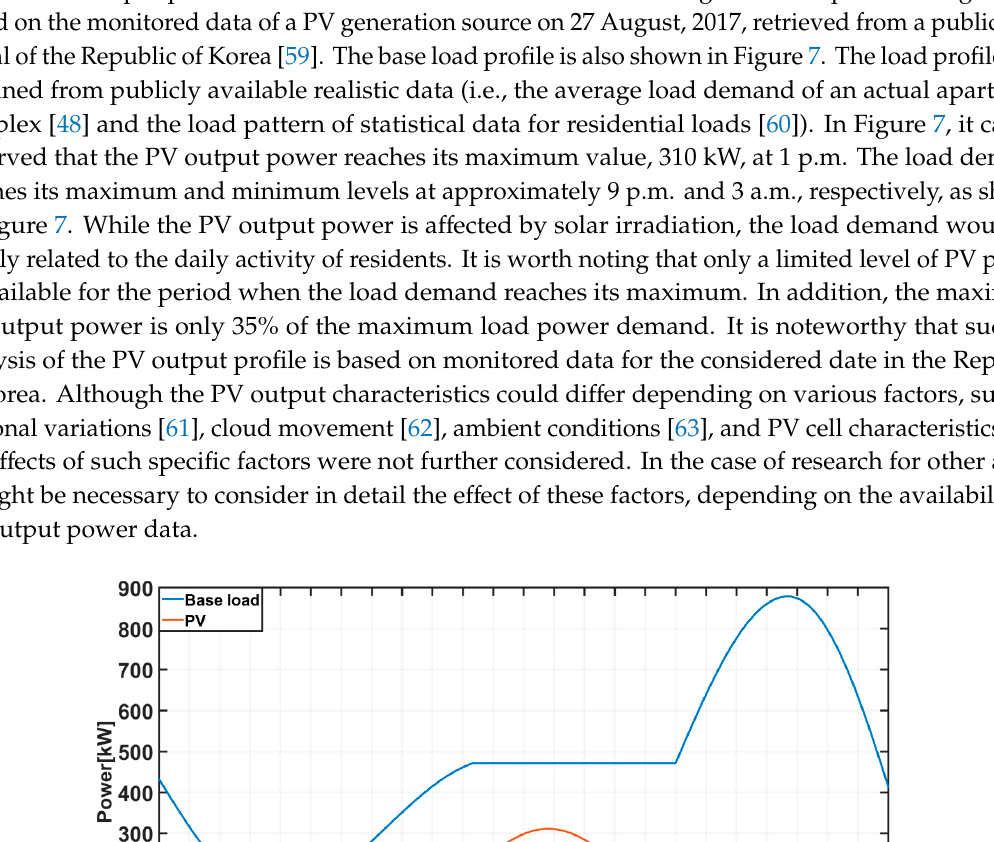
Figure 7. Simulated PV production profile.